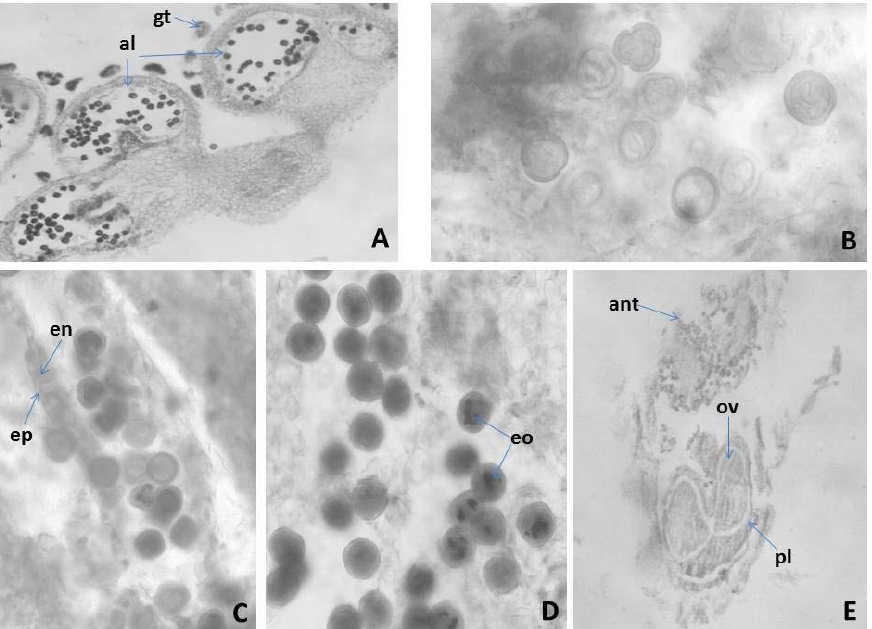
Figure 1. Anther and development of the male gametophyte revealed after light microscopy obser- vations: ( A ) tetrasporangiate anther; ( B ) two celled mature pollen grains; ( C ) mature pollen grains and anther wall with epidermis and fibrous endothecium; ( D ) mature pollen grains; ( E ) flower with anther and ovary; al—anther locule, gt—glandular trihomes, ep—epidermis, en—endothecium, eo—essential oil, pl—pistil, ant—anther, ov—ovule Magnification: ( A , E ) (×100); ( B – D ) (×400).